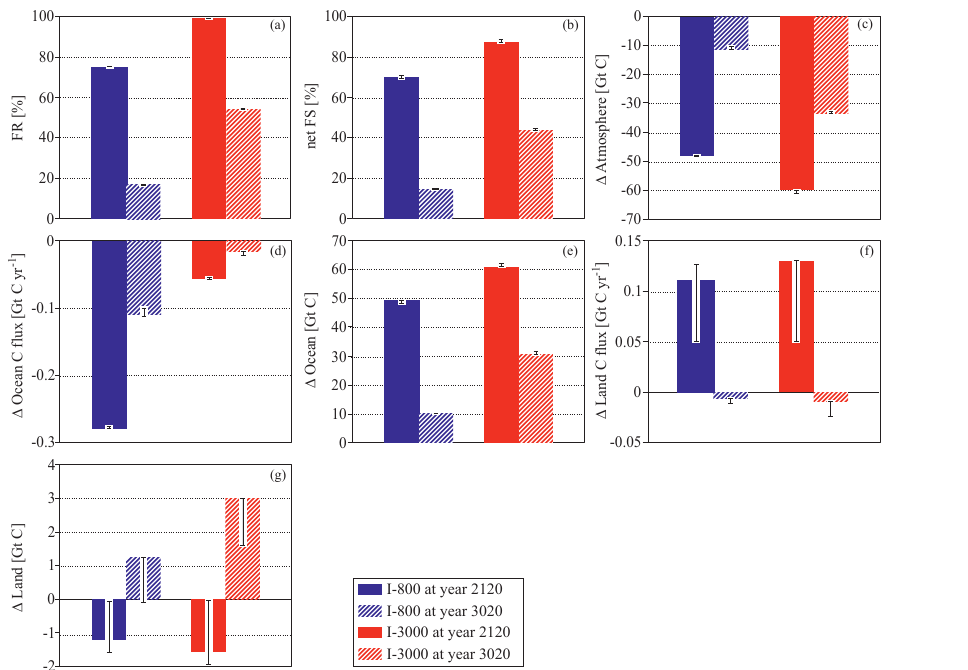
Figure 6. (a) Fraction retained (FR) for I-800 (blue) and I-3000 (red) for the years 2120 (filled) and 3020 (hashed) with error bars. In all panels, the error bars are defined as the difference of absolute changes between the perturbed injection runs and the respective control runs and the absolute change between the unperturbed injection runs and the control run of the With Emissions simulations. (b) Net fraction stored (netFS) for I-800 and I-3000 for the years 2120 and 3020 with error bars. Absolute changes in carbon between I-800 (I-3000) and the RCP 8.5 control run (With Emissions simulations minus RCP 8.5 control run) error bars for the years 2120 and 3020 for (c) globally integrated total atmospheric carbon, (d) globally integrated carbon flux from atmosphere to ocean, (e) globally integrated total oceanic carbon, (f) globally integrated carbon flux from atmosphere to land and (g) globally integrated total land